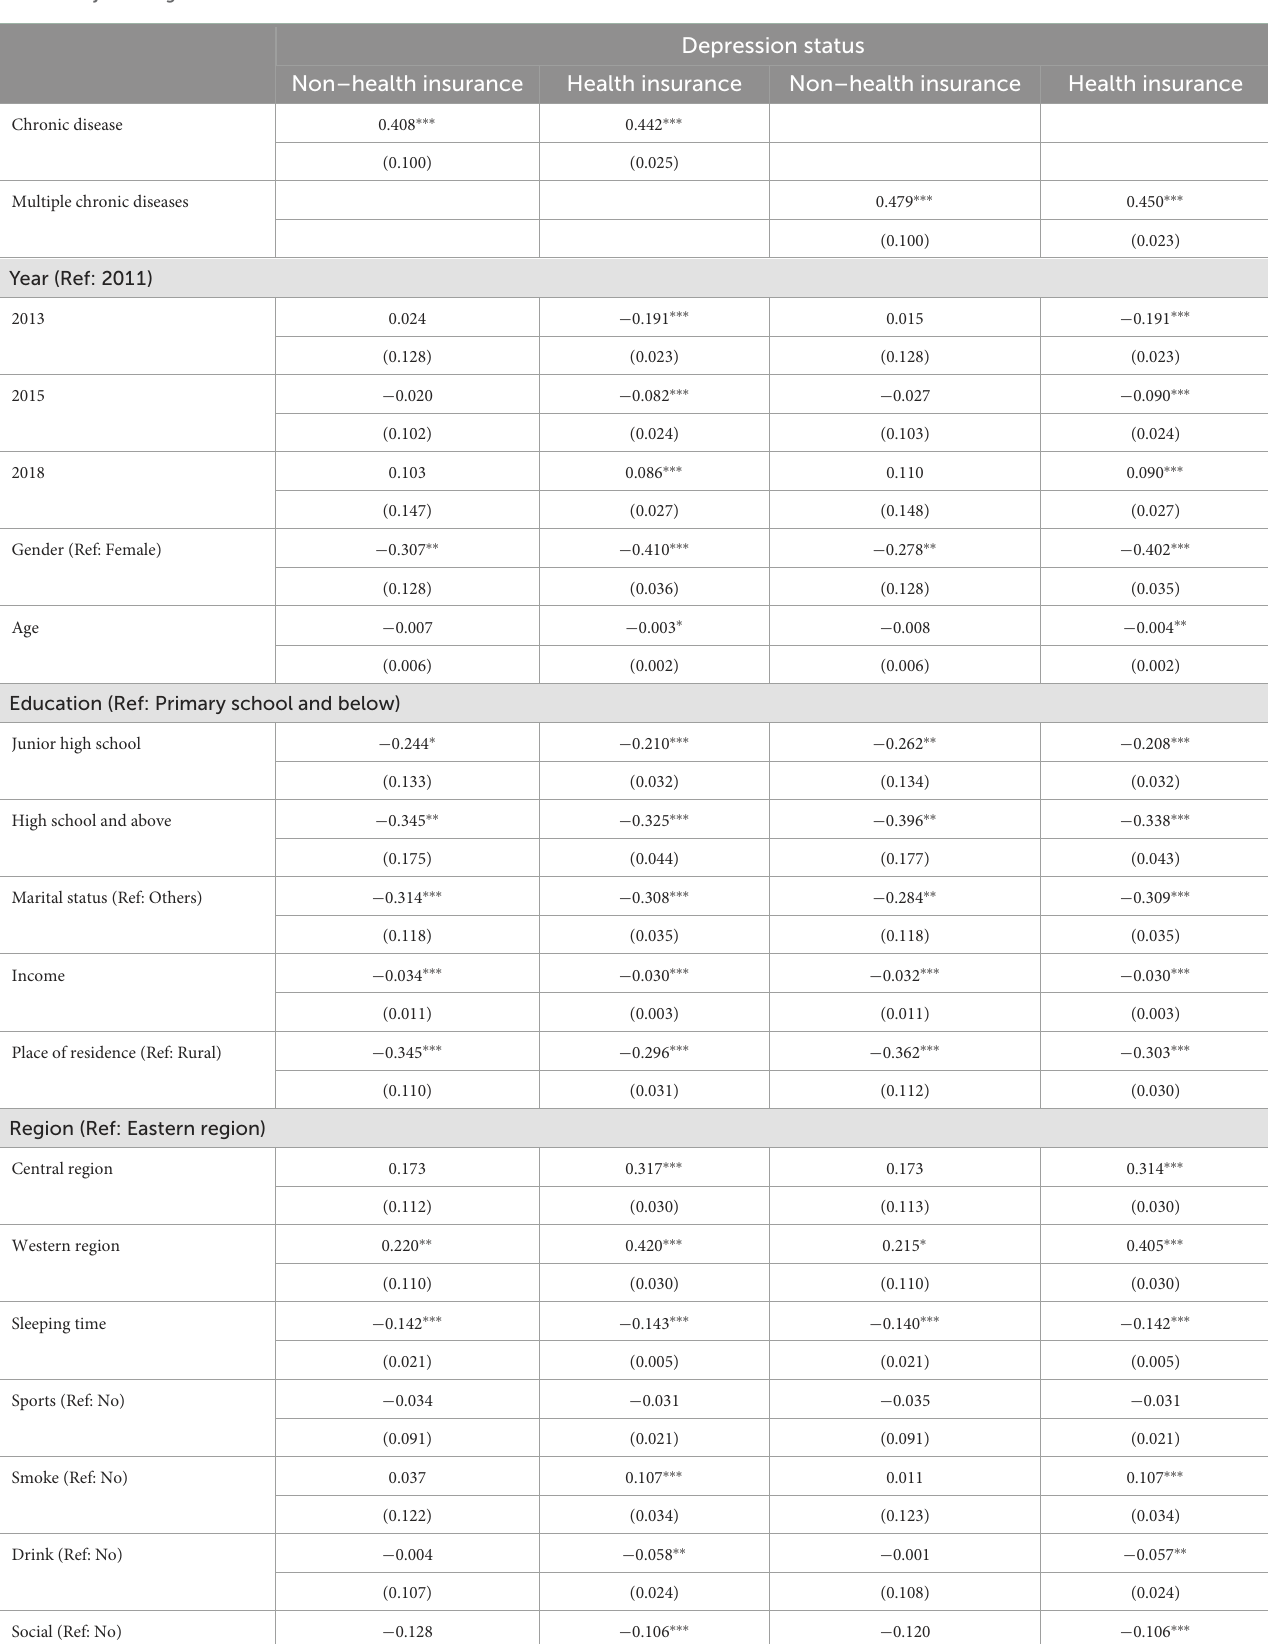
TABLE 5 Adjusted regression results of health